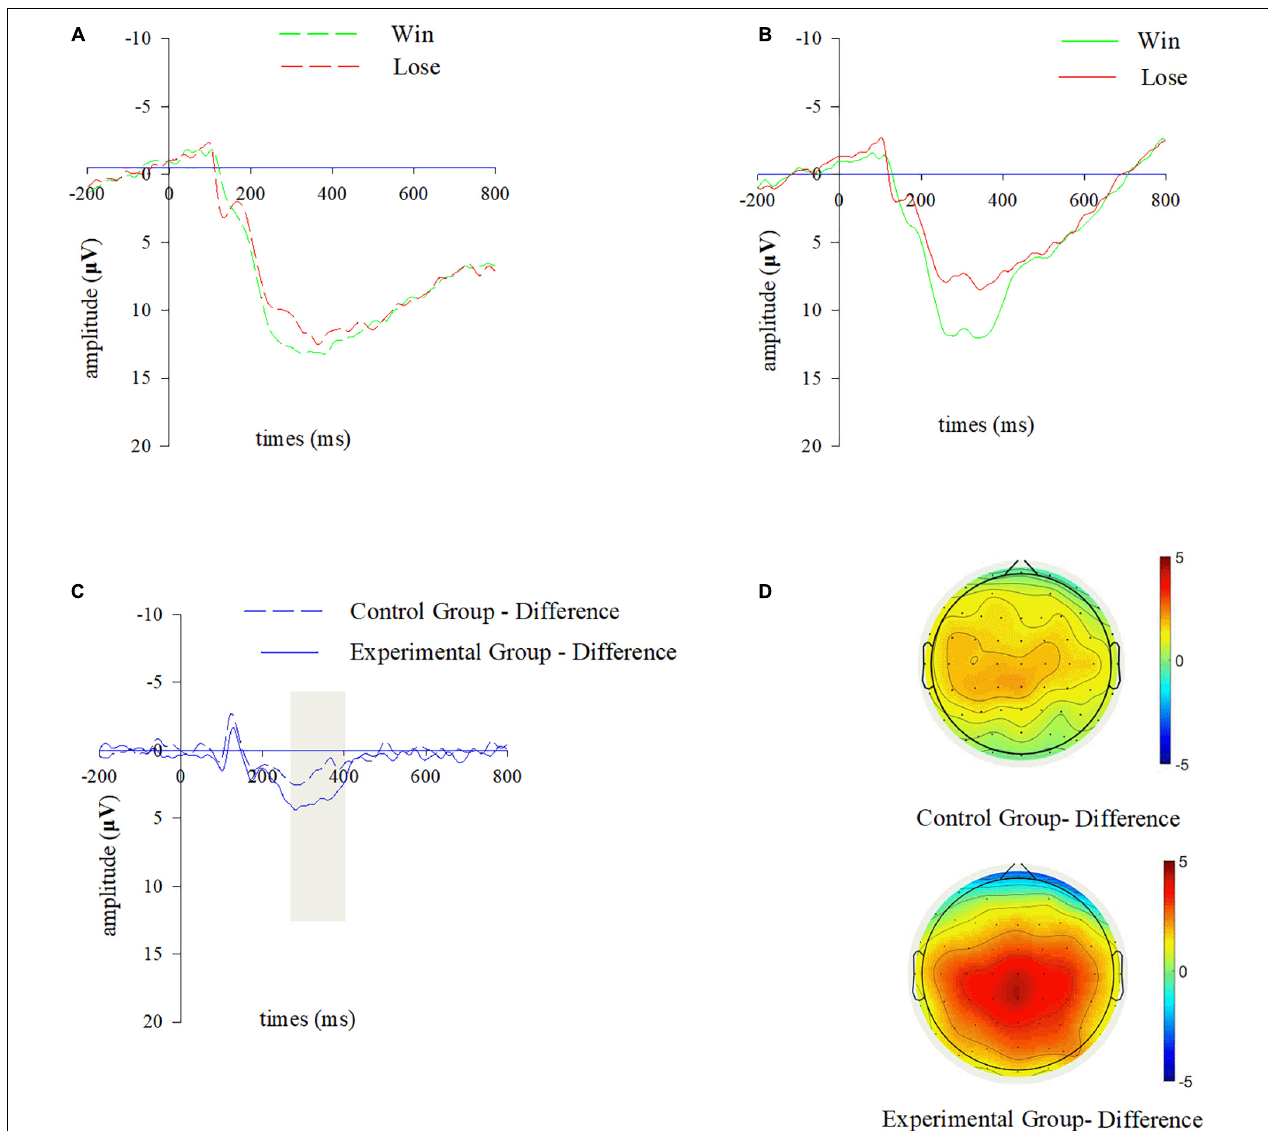
FIGURE 3 | P300 results during outcome evaluation. Grand-averaged ERP waveforms of P300 for wins and losses from the chosen electrode cluster (CP1, CPZ, CP2, P1, PZ, P2) for (A) the control group, and (B) the experimental group. (C) Difference waves of P300 (win-lose) from the chosen electrode cluster for two groups. (D) The scalp topographies of difference waves of P300 for two groups, and the bar for the topographic map ranges from –5 to 5 µ